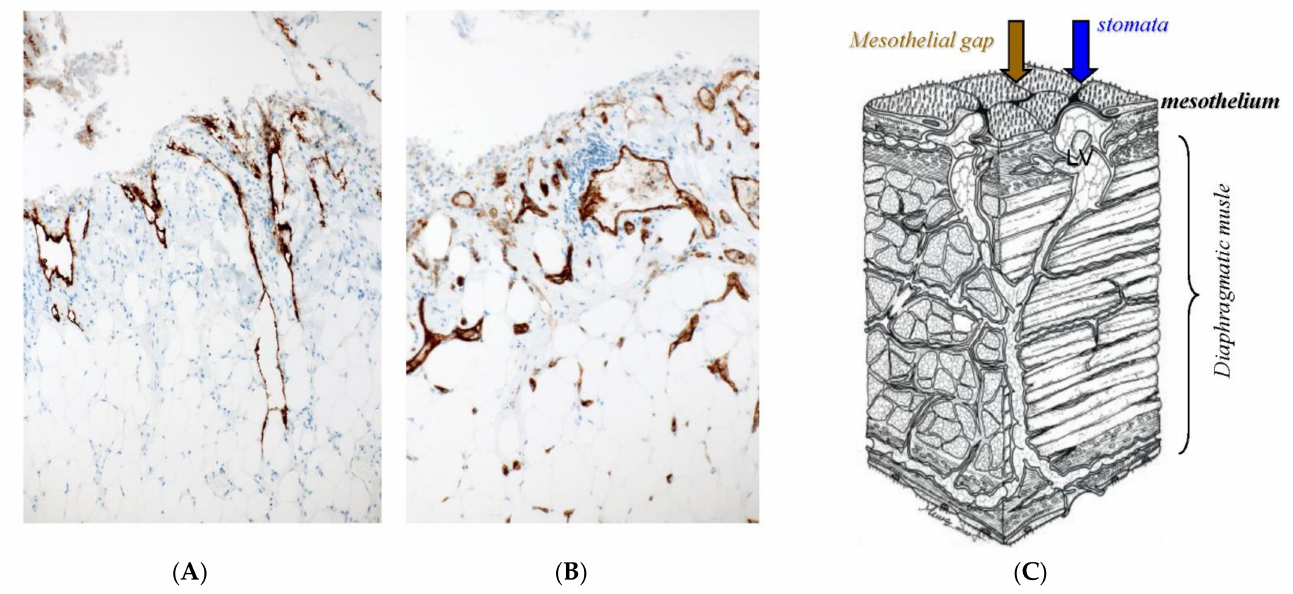
Figure 9. Lymph–vascular system of the diaphragm and the three-dimensional structure of the lymph–vascular network in the diaphragm. ( A ) D2-40 immunostaining. ( B ) CD31 immunostaining. ( C ) Schema of the diaphragmatic lymphatic system.